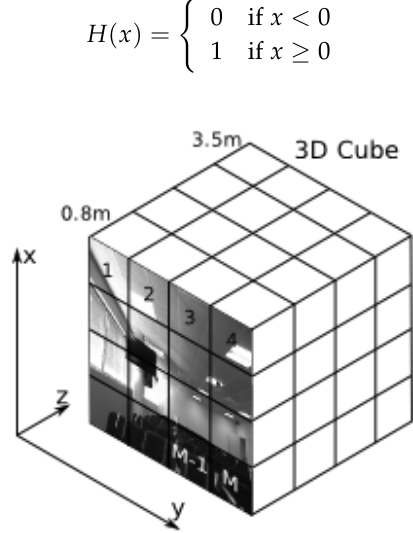
Figure 3. Representation of an RGB-D image as a cube. The XY plane is divided into a set of